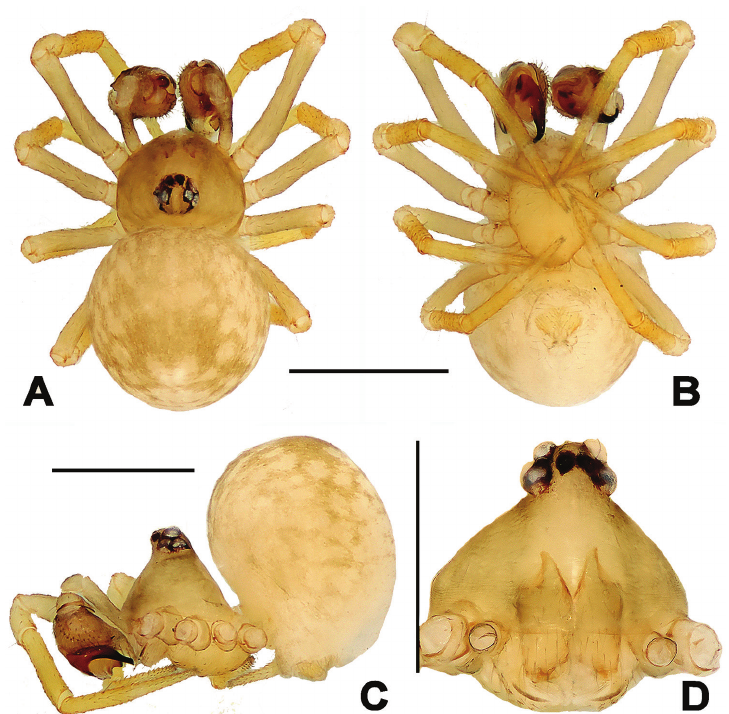
Figure 4. Trogloneta uncata Lin & Li, 2013, male ( A–D ). A–C Habitus D Prosoma (appendages omit- ted) A dorsal B ventral C lateral D anterior. Scale bars: 0.50